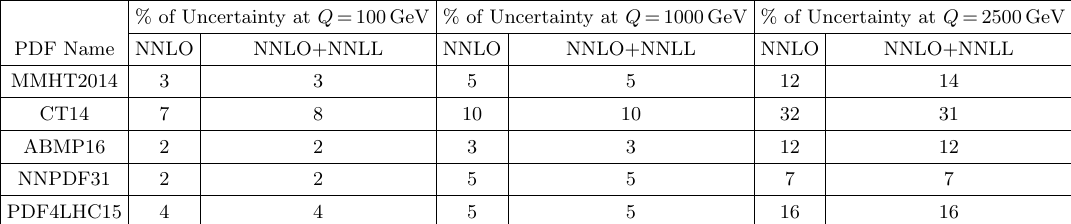
Table 3 . Intrinsic PDF uncertainties for di(cid:11)erent PDF choices. These uncertainties are given for both (cid:12)xed order as well as the resummed cross sections for a given value of Q = 100 ; 1000 ; 2500 GeV.